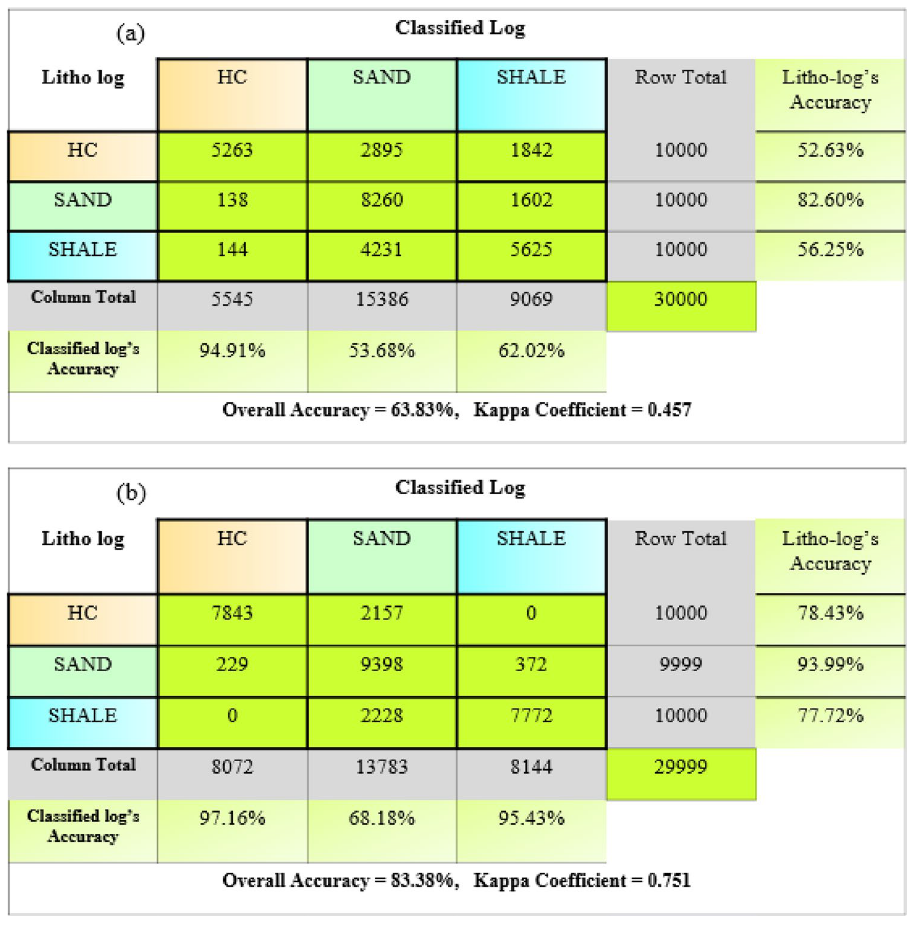
Figure 9. Confusion matrix Kappa coefficient and overall accuracy ( a ) conventional methodology ( b ) present